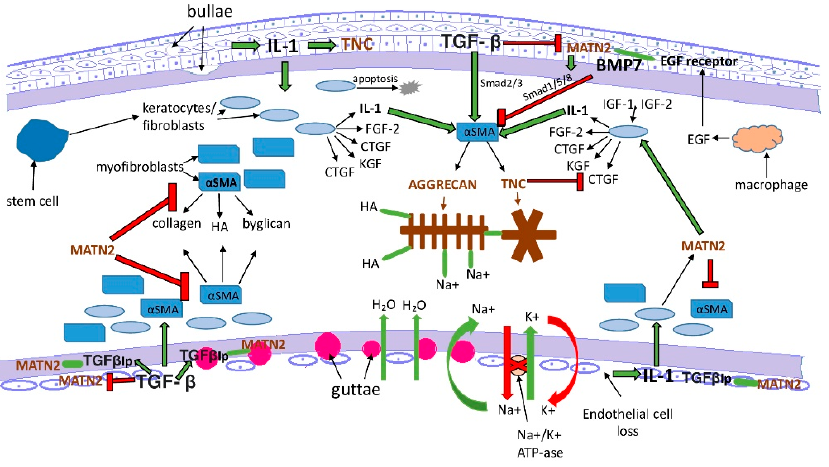
Figure 9. Proposed wound-healing mechanisms in FECD. The presence, distribution and the hypothesized bindings and effects of tenascin-C, matrilin-2 and aggrecan. α SMA = alpha smooth muscle actin, BMP7 = bone morphogenic factor 7, CTGF = connective tissue growth factor, EGF = epidermal growth factor, FGF-2 = fibroblast growth factor 2, HA = hyaluron acid, IGF-1 = insulin-like growth factor 1, IGF-2 = insulin-like growth factor 2, IL-1 = interleukin-1, KGF = keratocyte growth factor, MATN2 = matrilin-2, TGF- β = transforming growth factor beta, and TNC = tenascin-C. Green arrows with black contour = positive trigger, red arrows with black contour = inhibition, and green line = bounding. Some patients suffered from systemic diseases, such as NIDDM or RA in PBK